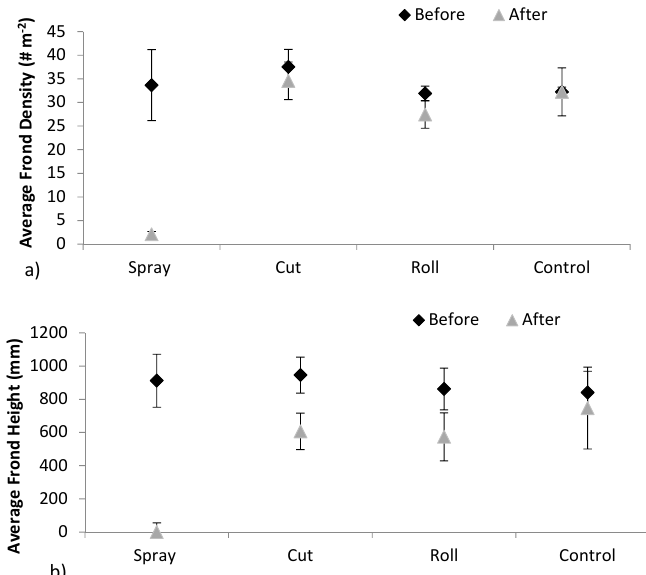
Figure 6. Bracken growth trends in ( a ) frond density and ( b ) frond height averaged across the 6 plot sites Whitepark Bay, Glenarm, Churchtown, Drumsurn, Bann Estuary and Murlough before and after treatment. (Error bars indicate standard deviations).